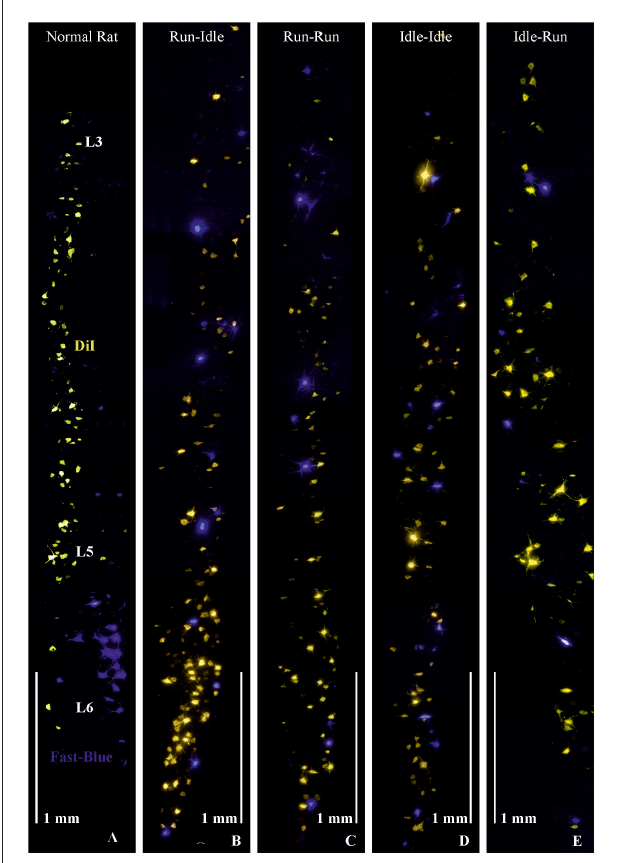
FIGURE1 Retrograde labeling of motoneurons in the lumbar spinal cord. (A) Normal rat, without graft transplantation, shows highly ordered columns of motoneurons of dorsiflexor muscles ( yellowish-orange ) retrogradely labeled by DiI applied to the common fibular nerve and plantar flexor motoneurons ( blue ) retrogradely labeled by Fast-Blue (FB) applied to the soleus nerve, indicating correct myotopic organization of motoneurons in the ventral (anterior) horn of the lumbar spinal cord (L3-L6). (B–E) These four images demonstrate chaotic and randomly misdirected regeneration of the common fibular and soleus nerves and complete loss of lumbar myotopy in all groups that received a 5-mm allograft nerve transplant. Note the random salt and pepper distribution of the retrogradely labeled motoneurons innervating the plantar flexor (blue labeling) and dorsiflexor (yellow labeling) muscles. Objective 10 × , scale bar